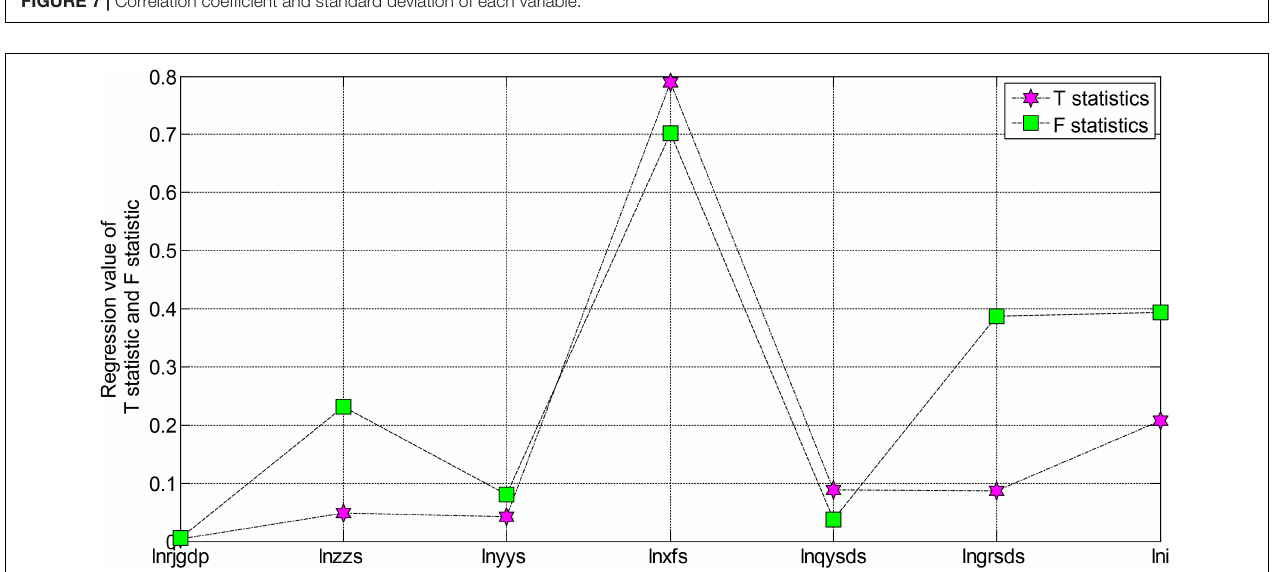
FIGURE 7 | Correlation coefficient and standard deviation of each variable.